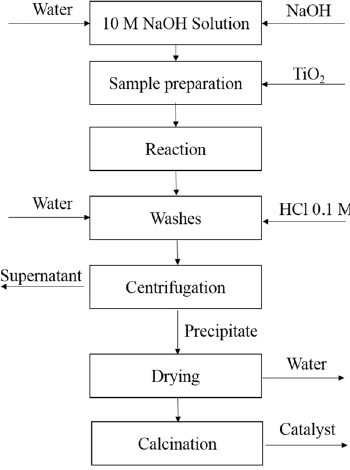
Figure 2. Schematic diagram of the hydrothermal synthesis method used. Table 1. Experimental runs of the 2 3 factorial